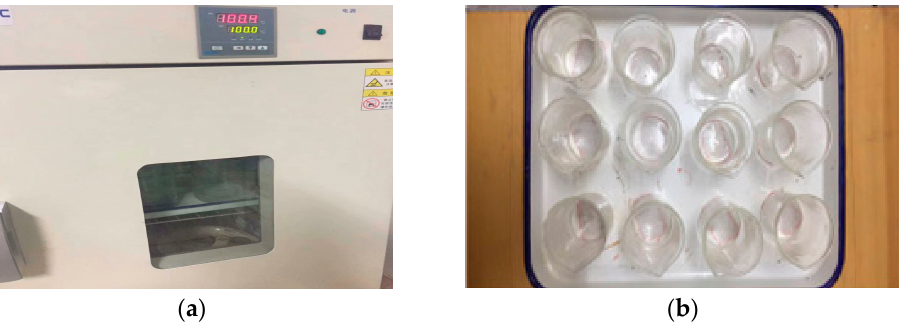
Figure 5. The evaporation test. (( a ) DHG-9140a, ( b ) The counting cup).